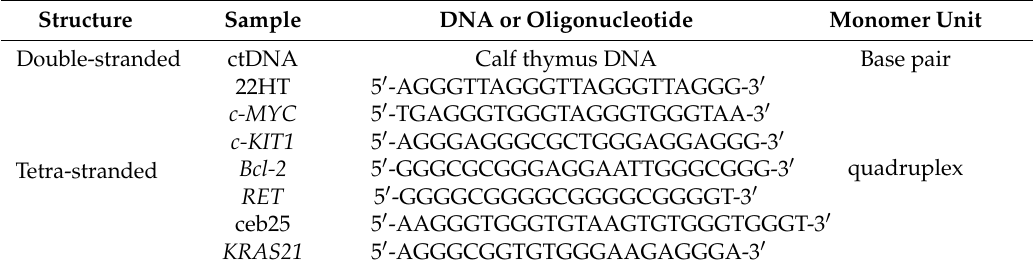
Figure 3. Results of competition dialysis experiment ( A , B ). The amount of carbazole ligands bound to the ctDNA and various G-quadruplexes is shown as a bar graph. The free ligand concentration in the experiment was 1 µ M, and the total concentration of each G-quadruplex was 75 µ M per G4 as a monomer unit. Structures of G-quadruplexes are described in Section 3.2 and Table 3. ( The affinity of ligands to 7 different forms of nucleic acids was also studied in the potassium-based buffer at room temperature. The samples of DNA included structures of G-quadruplexes represented by oligonucleotides which had human telomere sequence (22HT) and human protooncogene sequences ( c-MYC , c-KIT1 , bcl-2 , RET , ceb25 , KRAS21 ) (Table 3). All can form intramolecular G-quadruplex structures by folding of a single oligonucleotide molecule. Table 3. Nucleic acids samples used in equilibrium dialysis